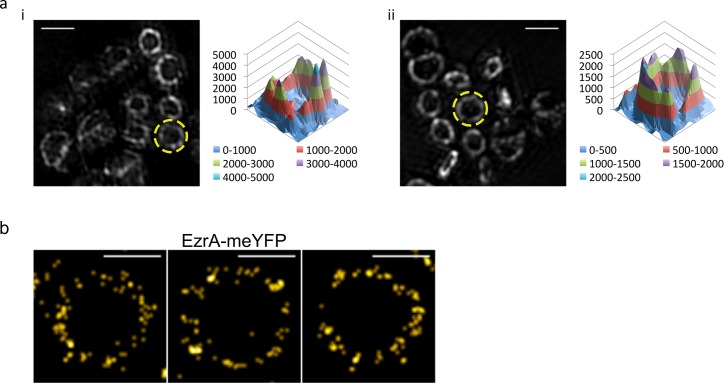
STORM and SIM data.(a) EzrA-GFP (i) and SNAP-Cell TMR-Star labelled EzrA-SNAP (ii) localisation in SH4640 (ezrA-gfp ΔezrA) and SH4642 (ezrA-snap ΔezrA) by 3D-SIM, respectively. The images are maximum intensity projections of reconstructed z stacks. Scale bars 1 μm. 3D surface profiles of the circled area show distribution of fluorescence intensity of EzrA-GFP and EzrA-SNAP TMR-Star rings. (b) Localisation microscopy of EzrA-meYFP in SH4604 (ezrA-meyfp ΔezrA).